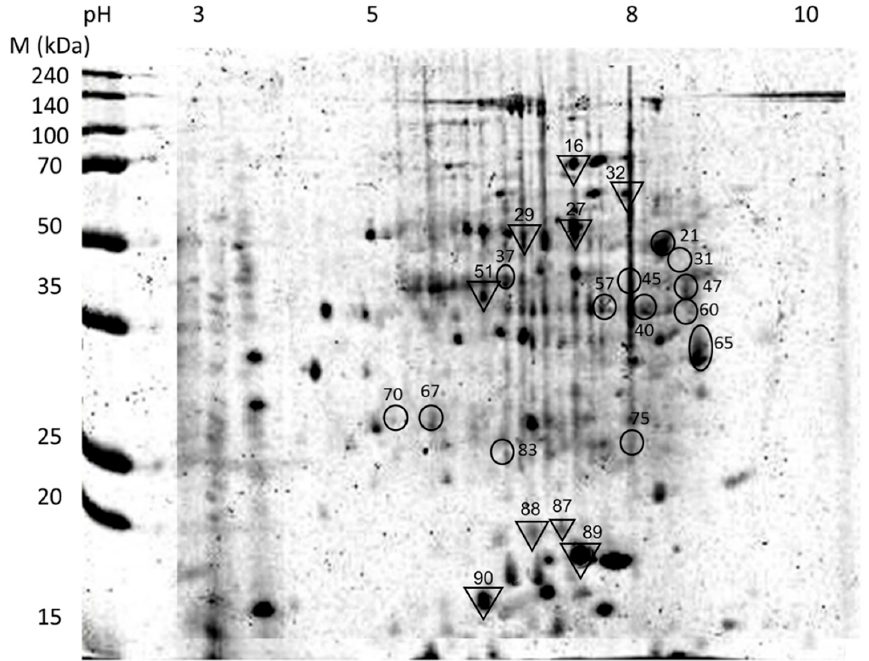
Figure 5. Two-dimensional electrophoresis merged master gel of separated total proteins from the fungus–termite interaction. Protein spots with significant expression are identified in Coptotermes curvignathus (circles) and Metarhizium anisopliae (reversed triangles). Numbers shown next to the protein spots are their respective protein IDs.